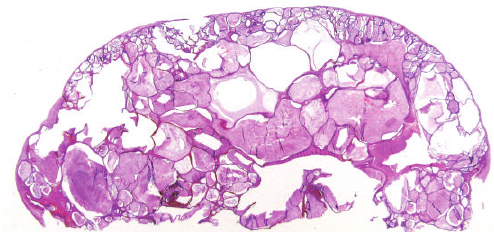
Figure 9: Mucinous cystoadenocarcinoma borderline of the ovary, measuring 11cm in greatest axis. A whole section of the tumour leads to a more accurate